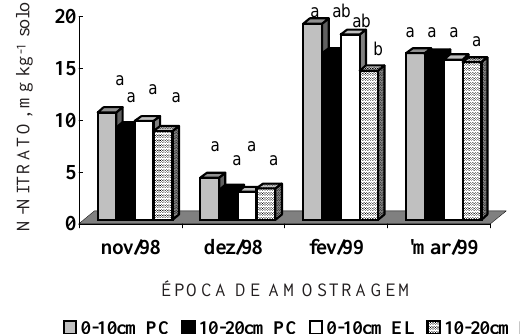
Figura 3. N-nitrato em Latossolo Vermelho distrófico cultivado com laranjeira em diferentes épocas, locais e profundidades de amostragem (PC = linha de projeção da copa, EL = entrelinhas). Letras comparam atividades dentro de cada época de amostragem a 5 % pelo teste de